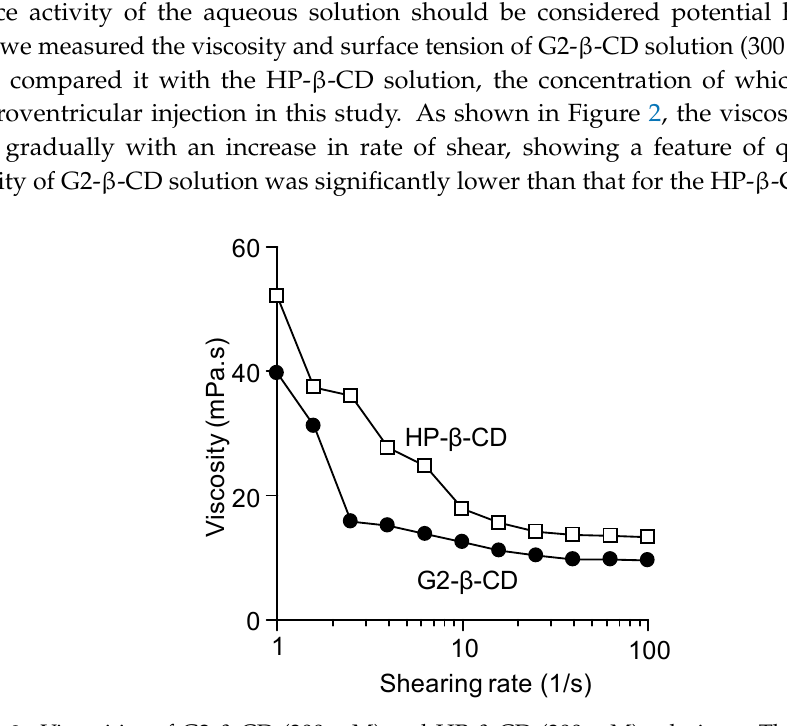
Figure 2. Viscosities of G2- β -CD (300 mM) and HP- β -CD (300 mM) solutions. The viscosities of G2- β -CD (closed circle) and HP- β -CD (open square) solutions were plotted as a function of shear rate. Table 1. Surface tensions of G2- β -CD and HP- β -CD solution (300 mM in ultra-pure water) measured by the du Nouy method.